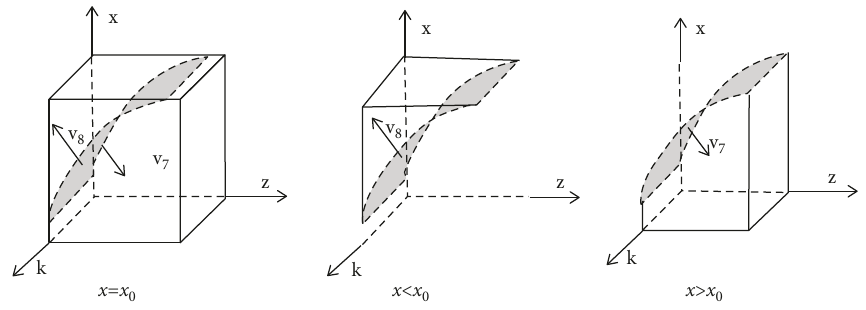
Figure 4: Replication dynamic phase diagram of Table 2: Analysis of the stability of the system when the government chooses to give particular support. Equilibrium